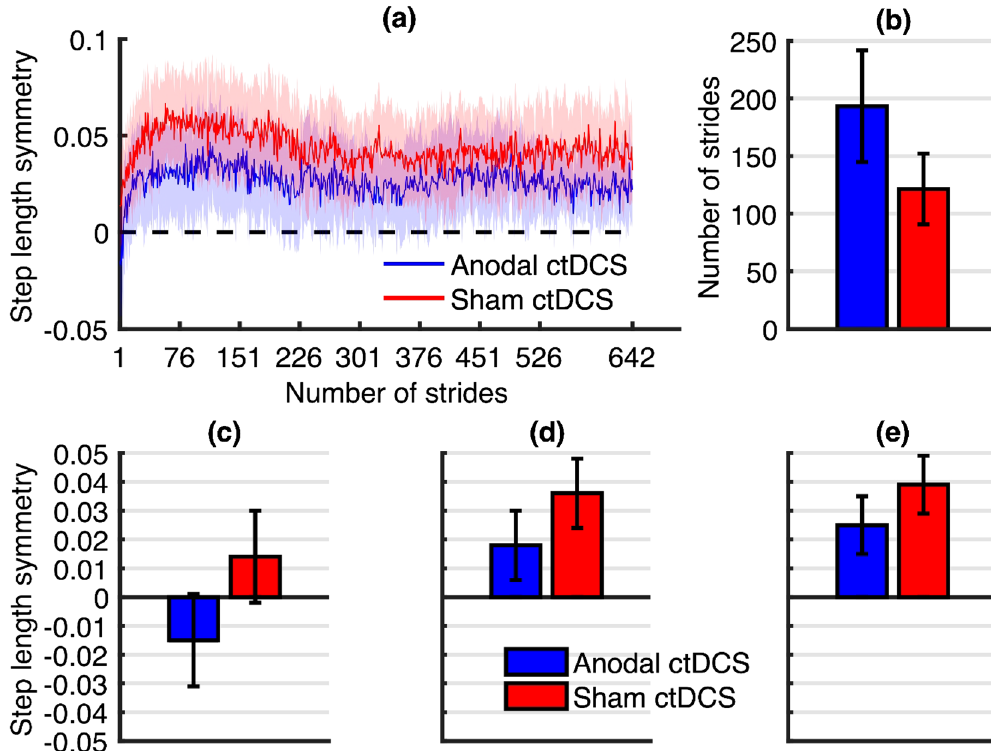
Figure 6. Graphs illustrating the results of the adaptation phase at the follow-up session. ( a ) Stride-by-stride mean step length symmetry plot for the anodal ctDCS group (blue) and sham ctDCS group (red) during the adaptation phase of the follow-up session. Lightly shaded areas indicate a 95% confidence interval. The inset bar graphs indicate mean estimates and standard error from the statistical models for ( b ) the number of strides to steady-state, ( c ) immediate adaptation, ( d ) early adaptation, ( e ) late